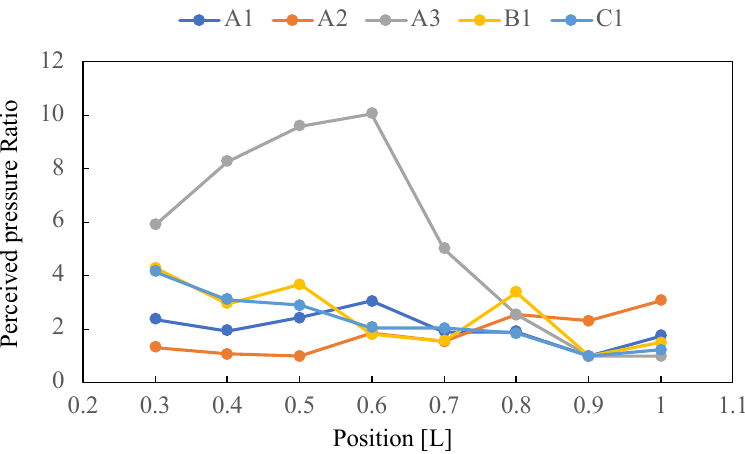
Figure 14. The perceived pressure ratio distribution.